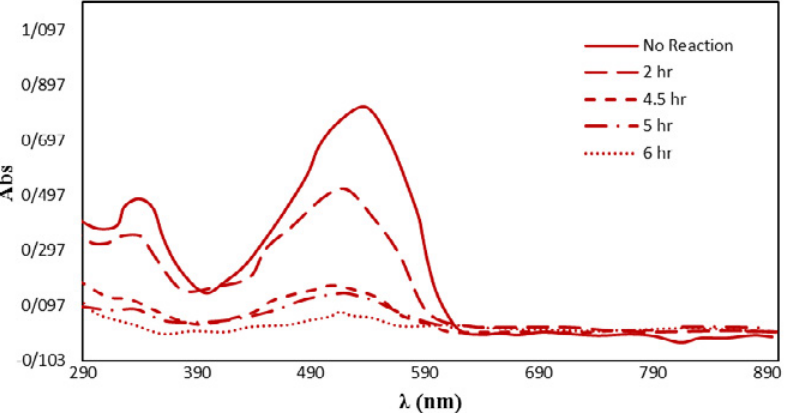
Fig. 15. Methyl orange spectrometry, Reactive Red 76, Acid Blue 15 and Acid Red 14 in light visible light and UV